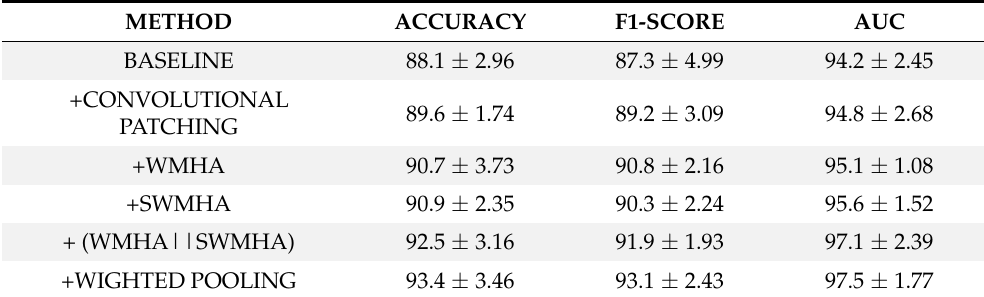
Table 4. Ablation experiments of the proposed model under 5-fold